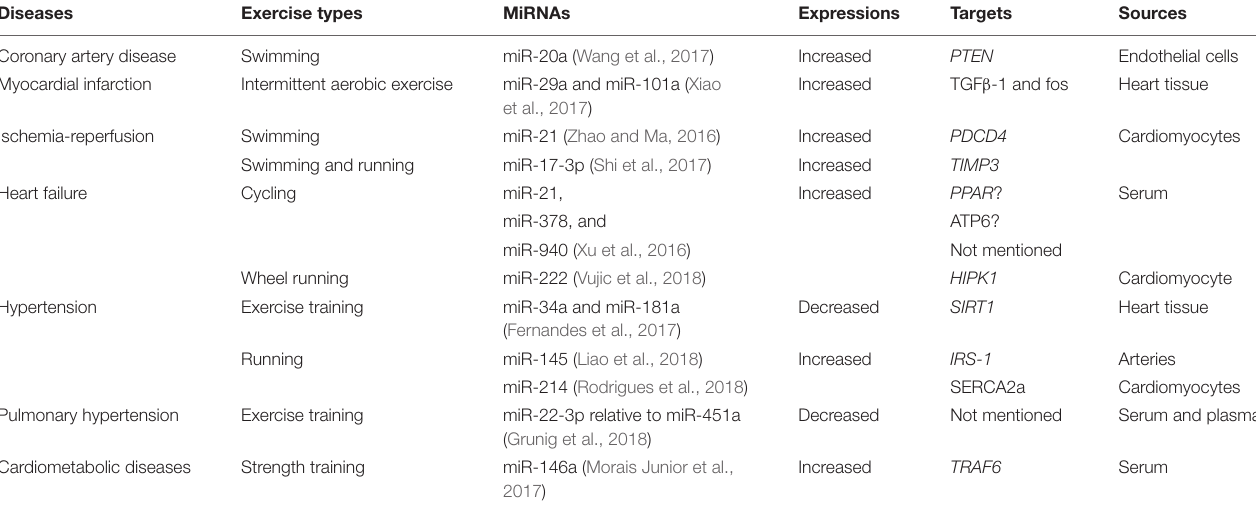
TABLE 1 | Changes of miRNAs after exercise in